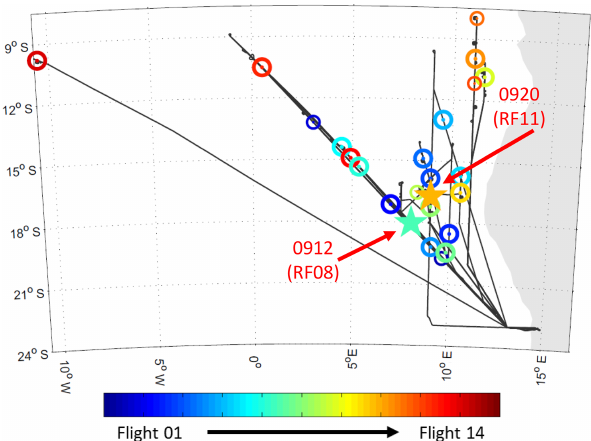
Figure 2. ORACLES-2016 P-3 flight paths (all flights; black lines) showing the approximate location of all aerosol comparison cases (circles). The cases highlighted in this paper (12 and 20 Septem- ber 2016) are indicated by a star and arrow, and larger circles are the cases included in the analysis in Sect. 3.2. The color indicates the timing of an individual case within the September 2016 deploy-